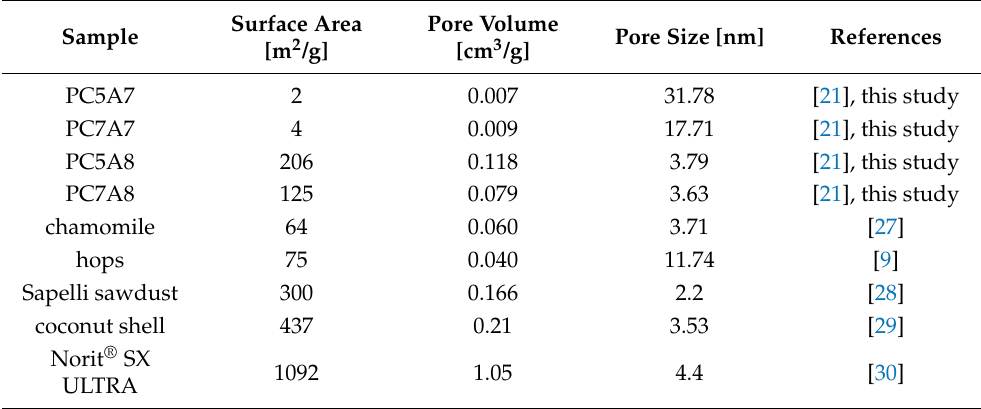
Table 1. Textural parameters obtained activated carbons compared with other